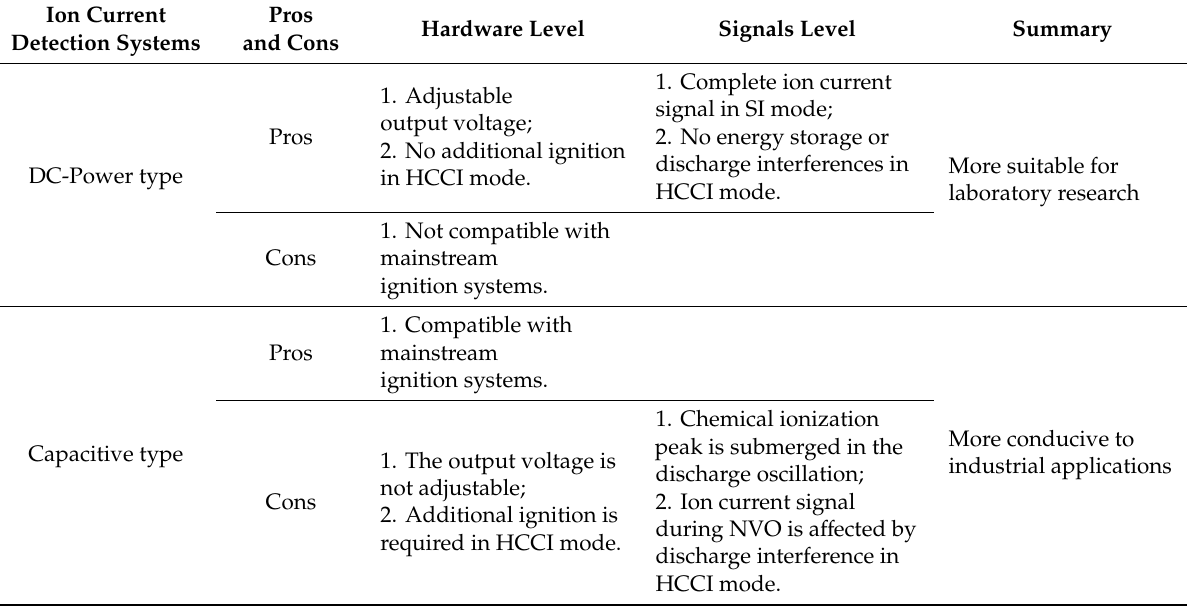
Table 1. Pros and cons of two ion current detection